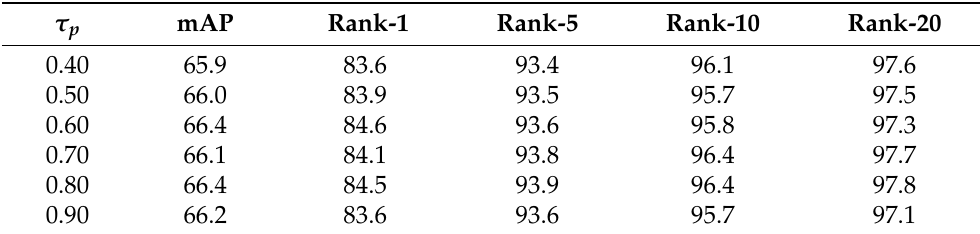
Figure 4. The influence of τ p on performance. Table 2. The influence of τ p on performance.